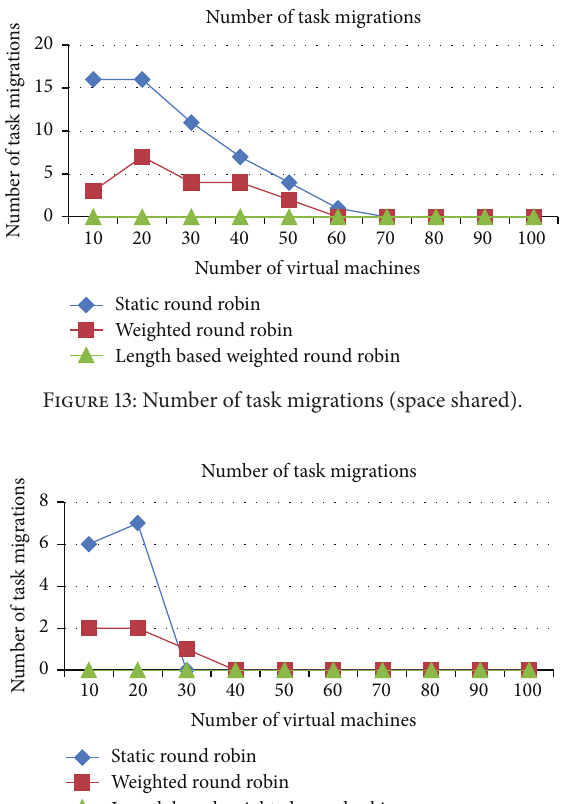
Figure 12: Execution completion time (time shared).